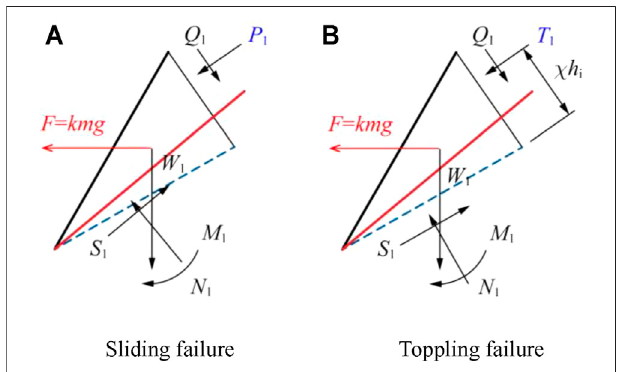
FIGURE3| Limitequilibriumanalysisofrockmass (A) Diagramofsliding failure in stratum layer; (B) Diagram of toppling failure, #1 at slope toe under horizontal pseudo-static load.